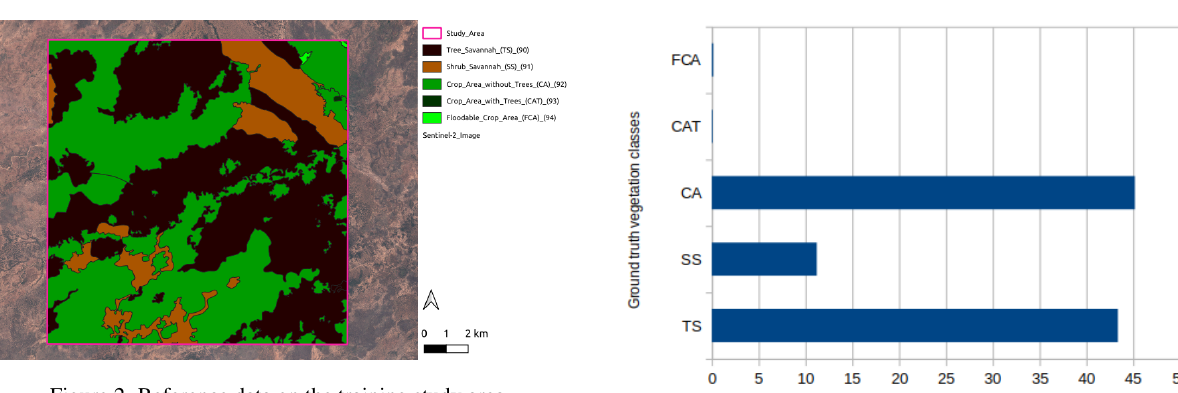
Figure 2. Reference data on the training study area.